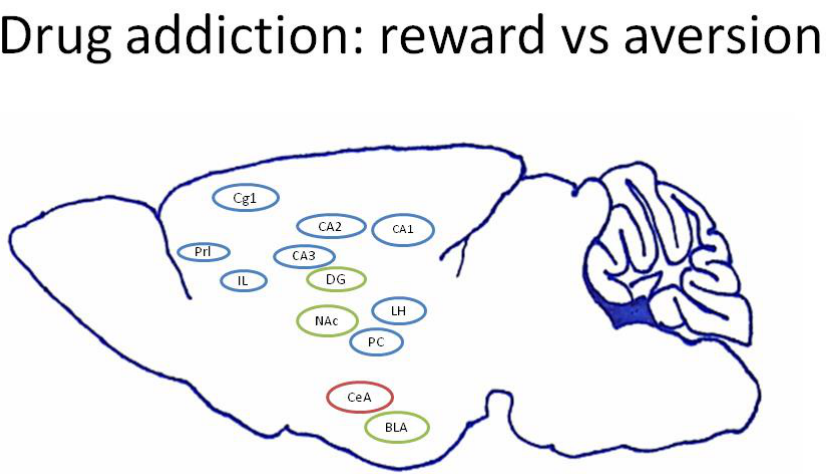
Figure 1. Representation of previous findings regarding neural substrates involved in reward and aversion during drug addiction. The selected neural substrates include the rewarding neural substrates, such as the cingulate cortex area 1 (Cg1), the prelimbic cortex (PrL), the infralimbic cortex (IL), the CA1, the CA2, the CA3, the lateral hypothalamus (LH), and the piriform cortex (PC), as well as the aversive neural substrates, such as the central amygdala (CeA). Other rewarding and aversive neural substrates include the nucleus accumbens (NAc), the basolateral amygdala (BLA), and the dentate gyrus (DG). Note: the rewarding, aversive, or both properties of neural substrates are, respectively, shown in the blue, red, and green circles.